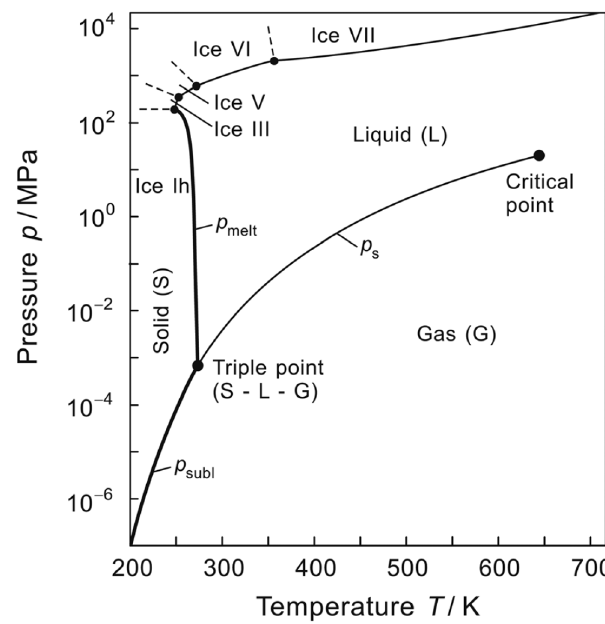
Figure 1. Temperature–pressure diagram of water (from IAPWS R14-08, 2011, permitted). The curves indicate phase transitions be- tween stable gaseous, liquid and solid states; p melt indicates the melting line of ambient hexagonal ice Ih, p subl its sublimation line and p s the saturation line, or boiling line, between liquid and gas. Several additional ice phases are not indicated. Within this diagram, geophysical conditions for ice, liquid water and water vapour cover only small regions (not shown) in the vicinity of the triple